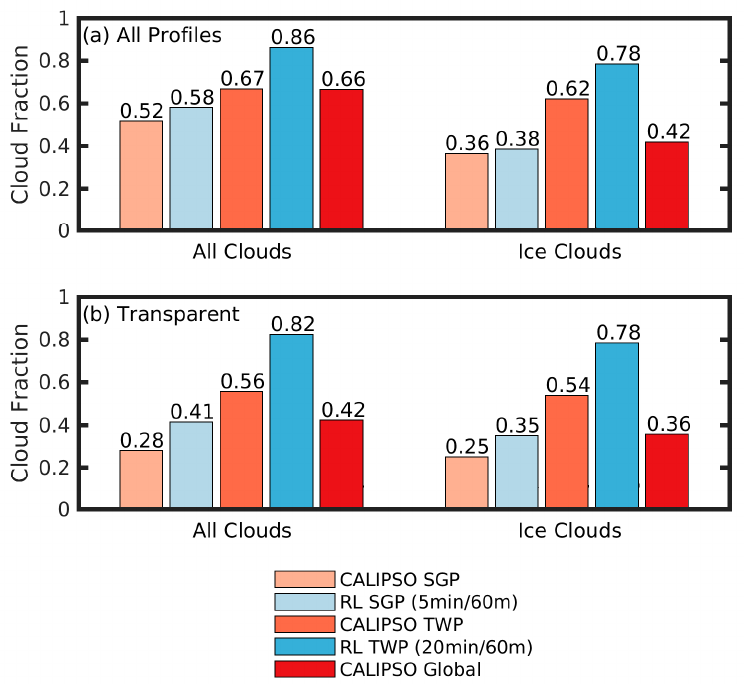
Figure 8. Cloud fractions of all clouds (left) and ice clouds (right). Cloud fractions are based on ( a ) all profiles and ( b ) transparent profiles for CALIPSO (red) and the RL (blue). Cloud fractions are for SGP (light color), TWP (medium color) and CALIPSO global (dark red). The RL resolution is the CALIPSO-like feature detection resolution (i.e., 5 min/60 m at SGP and 20 min/60 m at TWP). Values are also given above the bars. Data for the RL at the SGP site are from August 2008 to August 2016 and at the TWP site from December 2010 to January 2015. Data for CALIPSO are from June 2006 to August 2016.